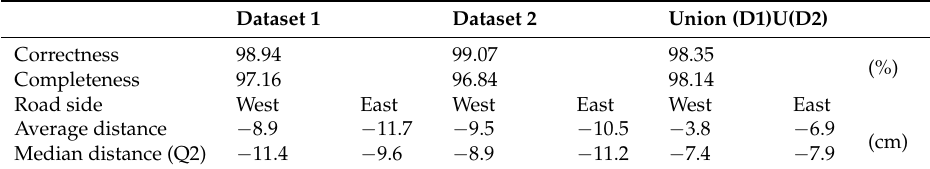
Table 2 . Area and distance performance metrics from the tests. Table 2. Area and distance performance metrics from the